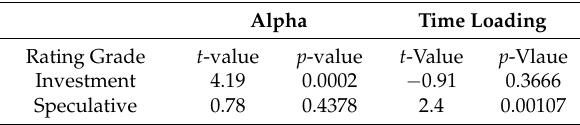
Table 8. Time Neutral of TS2.